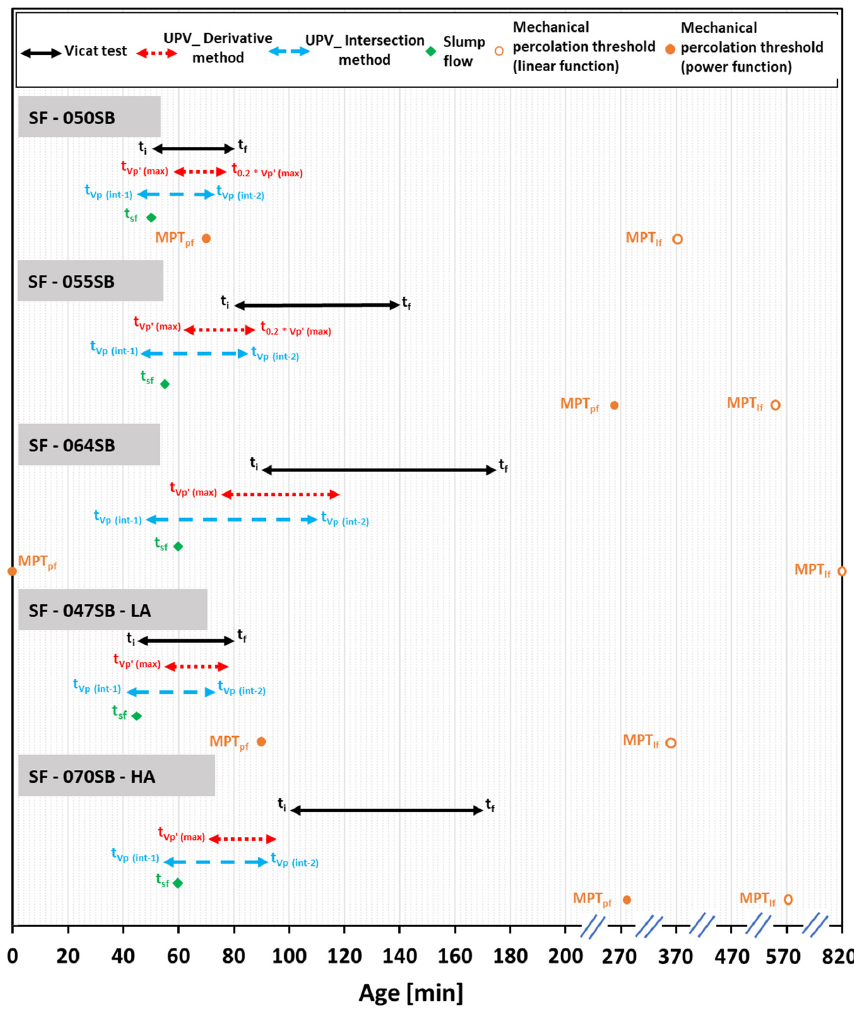
Figure 12. Timeline for Initial and final setting time values as obtained through various tech- niques.